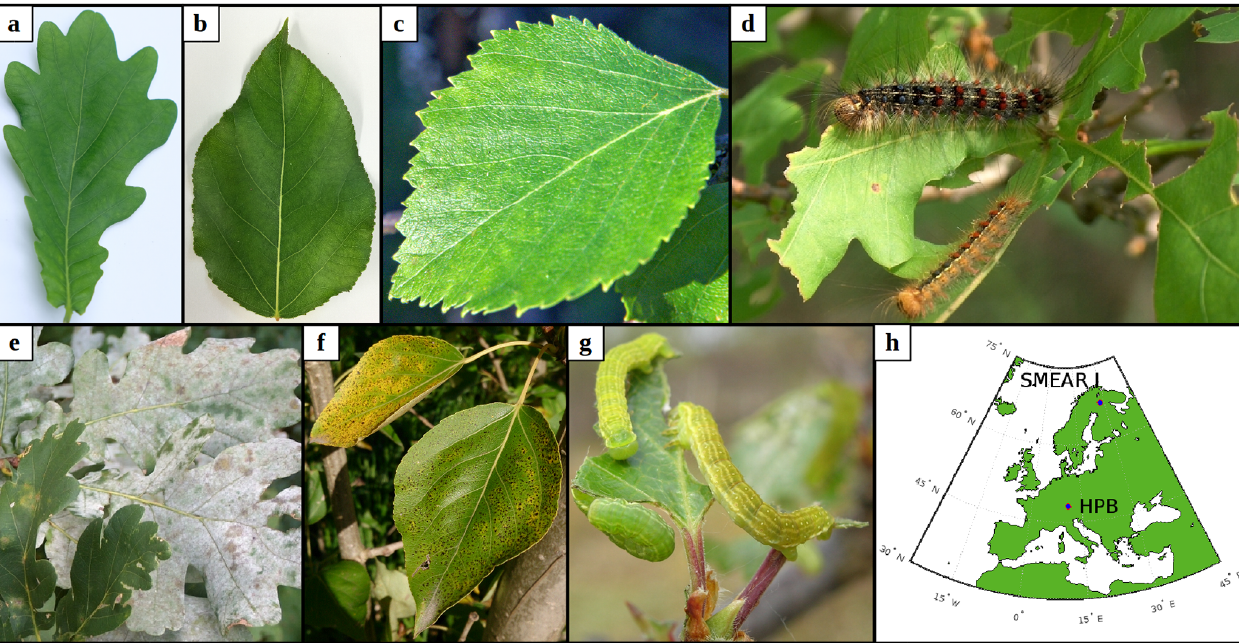
Figure 1. The plant species and biotic stresses we considered together with their locations. Panels (a–c) show examples of non-infected leaves of (a) pedunculate oak ( Quercus robur ), (b) balsam poplar ( Populus balsamifera var. suaveolens ), and (c) mountain birch ( Betula pubescens var. pumila ; former spp. czerepanovii ). Panels (d–g) show fungal-infected or moth-infested leaves of pedunculate oak infested by (d) European gypsy moth ( Lymantria dispar ) or infected by (e) oak powdery mildew ( Erysiphe alphitoides ), (f) poplar infected by rust fungus ( Melampsora larici-populina ), and (g) mountain birch infested by autumnal moth ( Epirrita autumnata ). (h) Locations of the two sites that serve as boundary conditions in our simulations. Photos are provided courtesy of (a, c) Juho Aalto, (b) Yifan Jiang, (d, e) Haruta Ovidiu (University of Oradea, Bugwood.org), (f) Ülo Niinemets, and (g) Tero